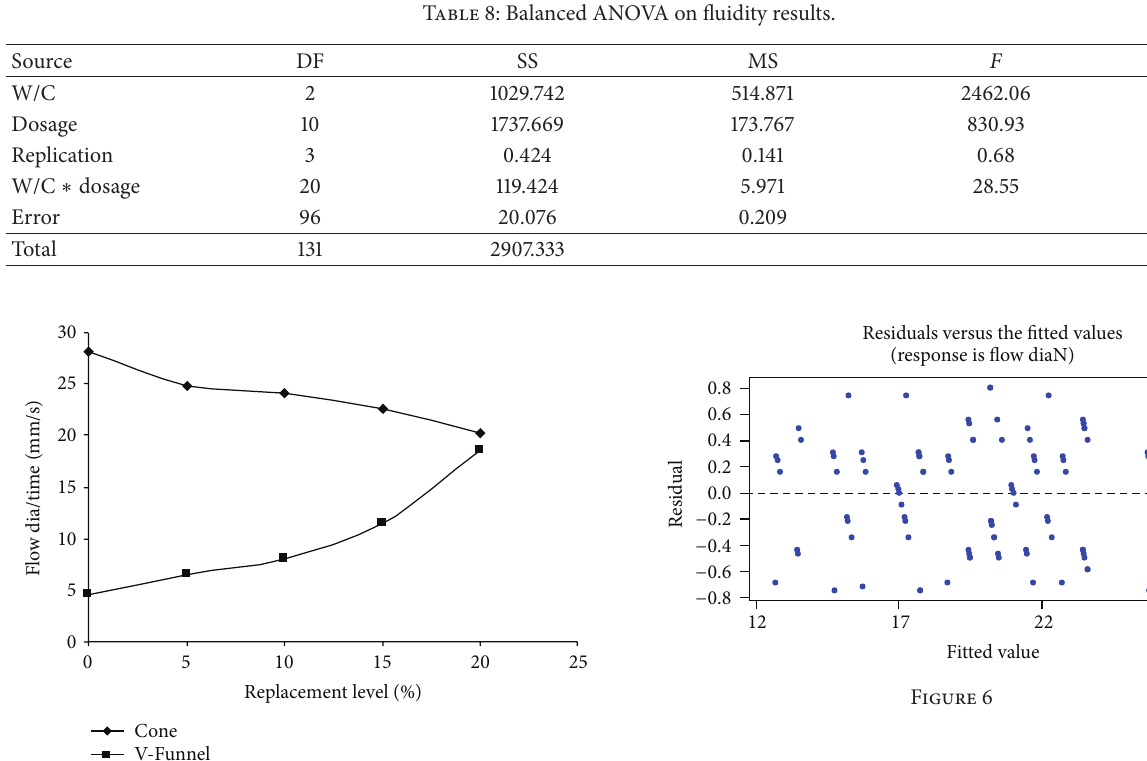
∗ Type of fly ash.